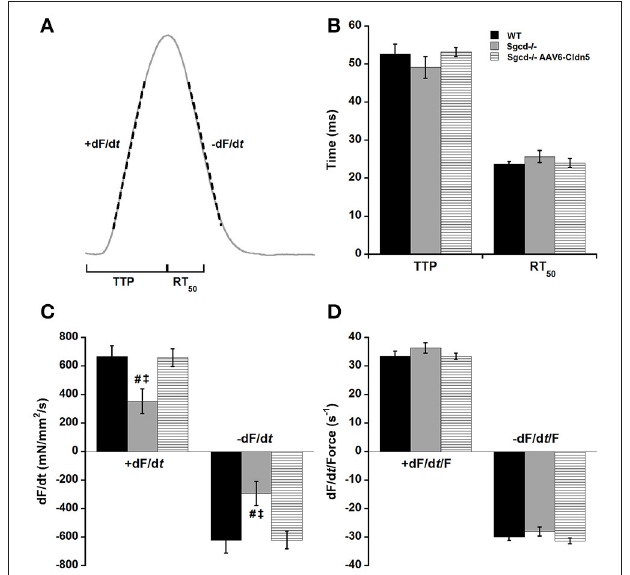
FIGURE 2 | Kinetics of contraction and relaxation are not affected by δ -sarcoglycan deficiency or claudin-5 gene therapy. (A) Schematic representation of the kinetic parameters assessed in cardiac trabeculae. TTP: time to peak tension, time from stimulation to peak force, RT 50 : relaxation time from peak force to 50% relaxation. + dF/d t , maximal velocity of contraction; − dF/d t , maximal velocity of relaxation. (B) TTP and RT 50 are similar in muscles from wild-type (WT), Sgcd − / − , and Sgcd − / − mice treated with AAV6-Cldn5 ( Sgcd − / − AAV6-Cldn5). (C) + dF/d t and − dF/d t are lower in the Sgcd − / − compared with both WT and Sgcd − / − AAV6-Cldn5 groups. (D) Normalizing the + dF/d t and − dF/d t to the developed force reveals that the kinetics of contraction and relaxation themselves are preserved across all three groups. # , Signify P < 0.05 Sgcd − / − vs. WT and Sgcd − / − vs. Sgcd − / − AAV6-Cldn5 as assessed with Bonferroni post-hoc , respectively. All measurements made at optimal length, 4 Hz, and 37 ◦ C. The numbers of mice of each group from which muscles were measured and included in the analysis were: WT ( n = 7, 3M, 4F); Sgcd − / − ( n = 7, 2M, 5F); Sgcd − / − AAV6-Cldn5 ( n = 6, 5M, 1F).